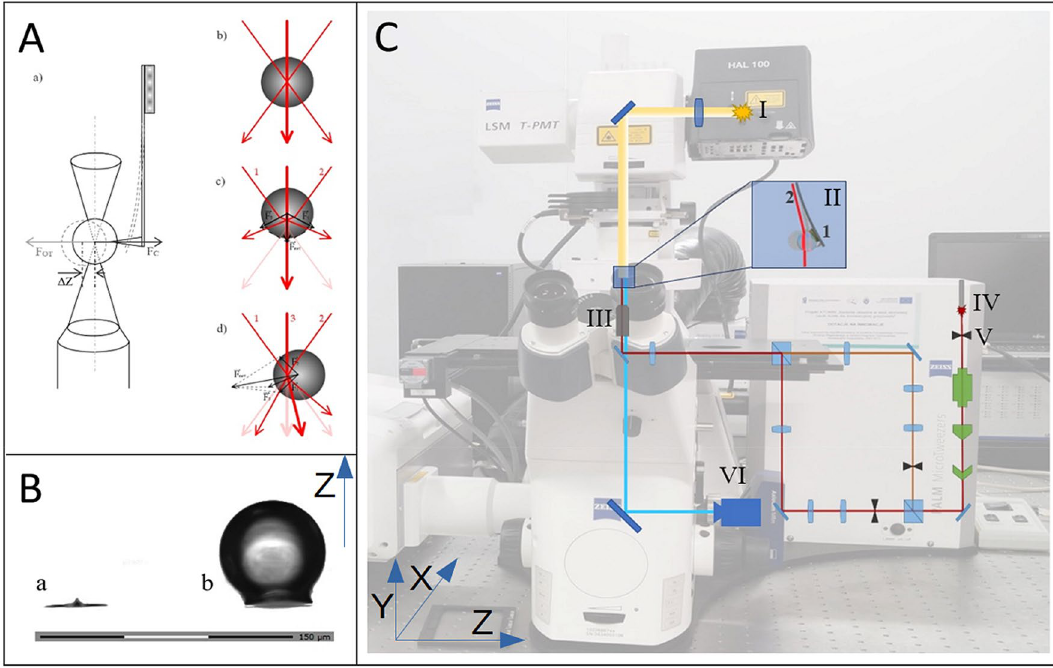
Figure 1. Left panel: ( A ) The scheme of experimental setup (a) and force distribution on a glass particle treated with the laser beam generated by OT (b–d) 32 ; ( B ) Transmitted light microscopy image presenting AFM cantilever before (a) and after (b) glass particle attachment.. Right panel: ( C ) The image of experimental setup with the scheme showing the course of the OT laser beam and the optical path of the microscope.